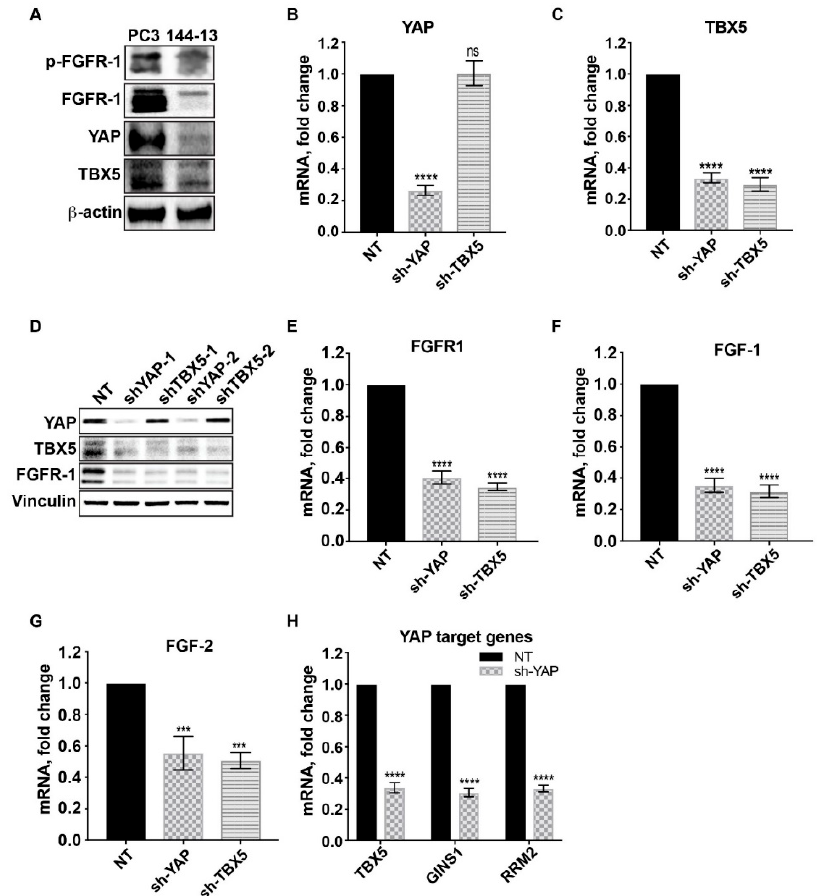
Figure 3. FGF and FGFR1 expression is induced by a YAP/TBX5-dependent mechanism. ( A